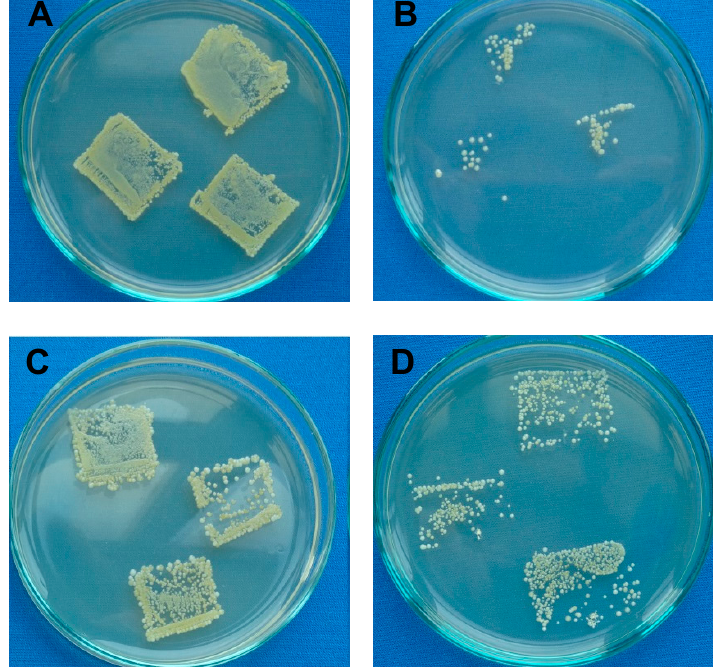
Figure 9. Example of total microbial counts of LDPE samples on plate count agar with inoculated bacteria: ( A ) untreated ( S. aureus ); ( B ) ASA-grafted ( S. aureus ); ( C ) untreated ( E. coli ); ( D ) ASA-grafted ( E. coli ).